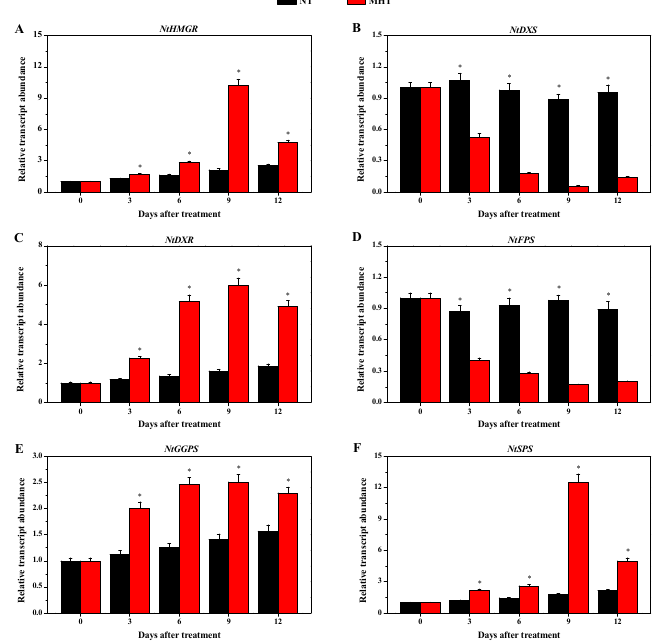
Figure 5. Relative transcript abundance of selected solanesol biosynthesis genes as measured by quantitative real-time PCR (qRT-PCR) using tobacco leaves grown at normal temperature (NT) and moderately high temperature (MHT). ( A ) N. tabacum 3-hydroxy-3-methylglutaryl-CoA reductase ( NtHMGR ), ( B ) N. tabacum 1-deoxy- D -xylulose 5-phosphate synthase ( NtDXS ), ( C ) N. tabacum 1-deoxy- D -xylulose 5-phosphate reductoisomerase ( NtDXR ), ( D ) N. tabacum farnesyl diphosphate synthase ( NtFPS ), ( E ) N. tabacum geranylgeranyl diphosphate synthase ( NtGGPS ), and ( F ) N. tabacum solanesyl diphosphate synthase ( NtSPS ). The asterisk (*) indicates p < 0.05.